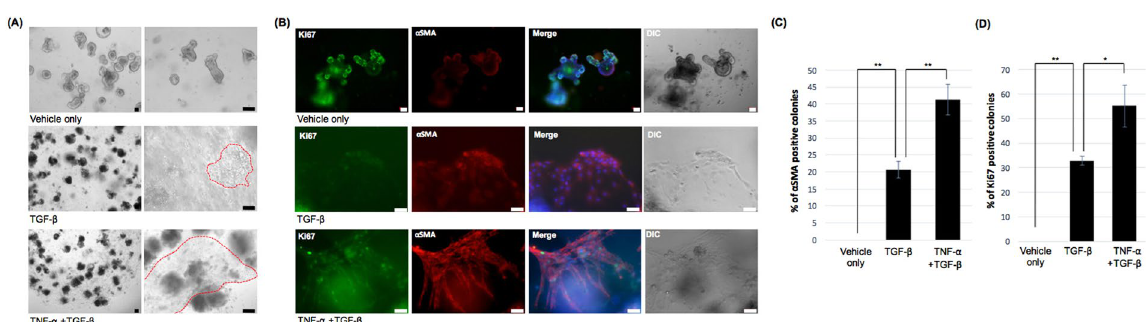
Figure 4. Pretreatment of TNF- α can synergistically induce mesenchymal changes in TGF- β treated IEOs derived from the mouse colon. ( A ) Representative images of mesenchymal changes and migratory cells in cIEOs treated with TNF- α and TGF- β 1. Bars, 100 μ m. Red arrow, migrating cells. ( B ) The expression of α -SMA and Ki67 was examined in TGF- β and TNF- α treated cIEOs. Bars, 50 μ m. ( C ) The percentage of α -SMA positive colonies among all the colonies was determined. ( D ) The percentage of Ki67 positive colonies among all the colonies was determined. Data are presented as the mean ± SEM; n = 4 samples per bar, ** p < 0.01, * p <